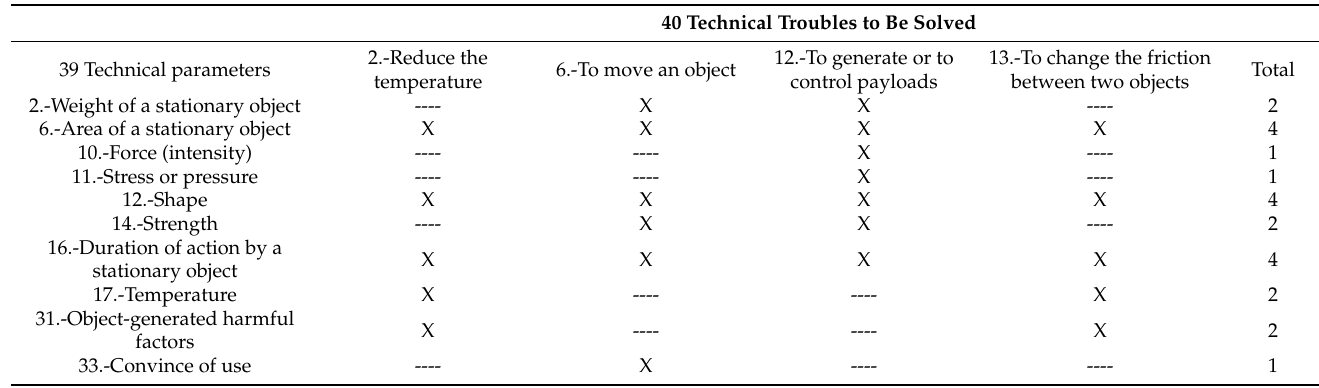
Table 3. Main design parameters for the proposed dynamic wheelchair.